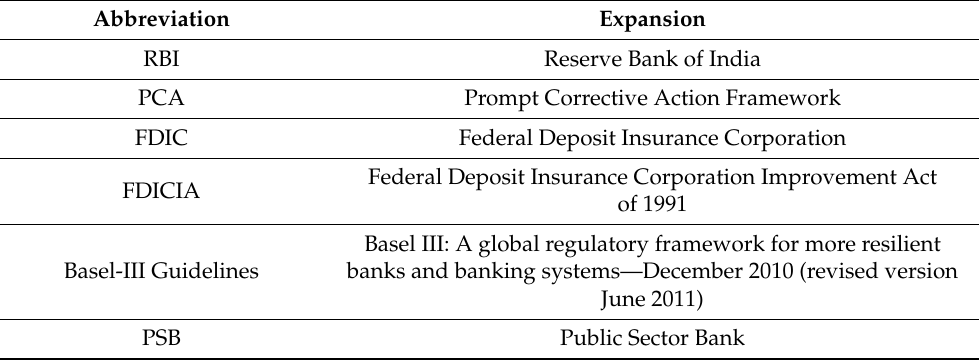
Table A15. List of abbreviations of key terms used in the